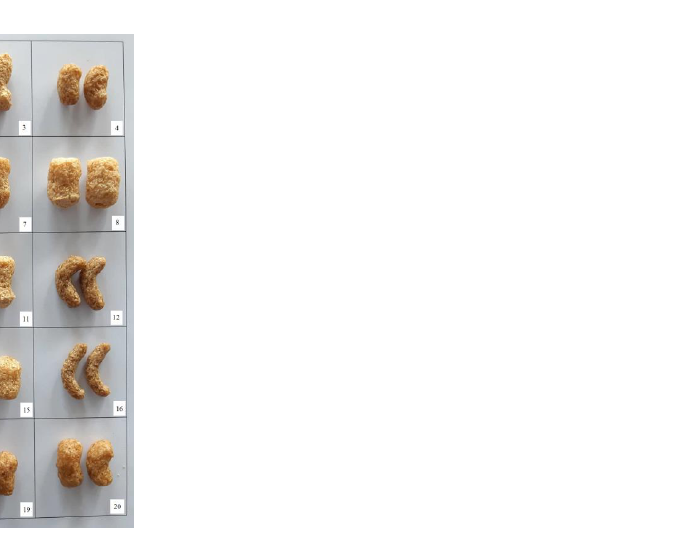
Figure 1. Rice-based chicory root enriched extrudates obtained following CCD. Sample numbers (1 – 20) refer to different extrusion conditions defined by CCD obtained through varying moisture content (16.3 – 22.5%), screw speed (500 – 900 rpm), and chicory root content (20 – 40%).